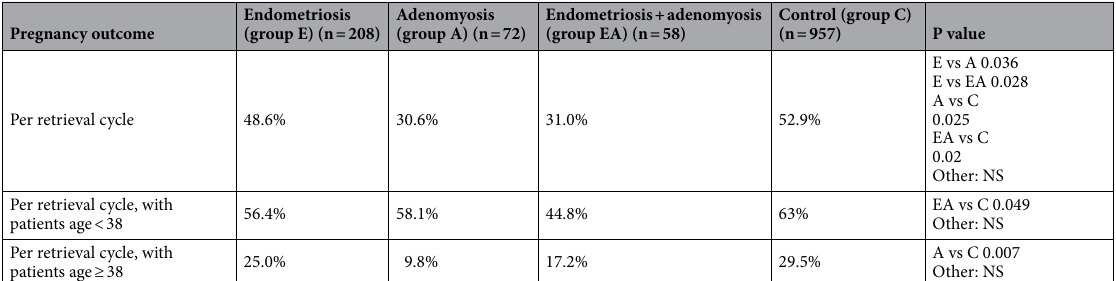
Pregnancy outcome